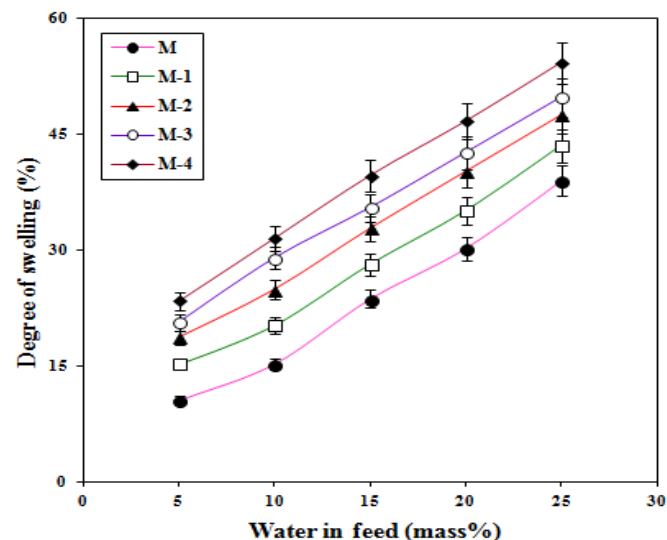
Figure 5. Variation of the degree of swelling with different composition in the feed for crosslinked NaAlg and membranes incorporating TiO 2 .